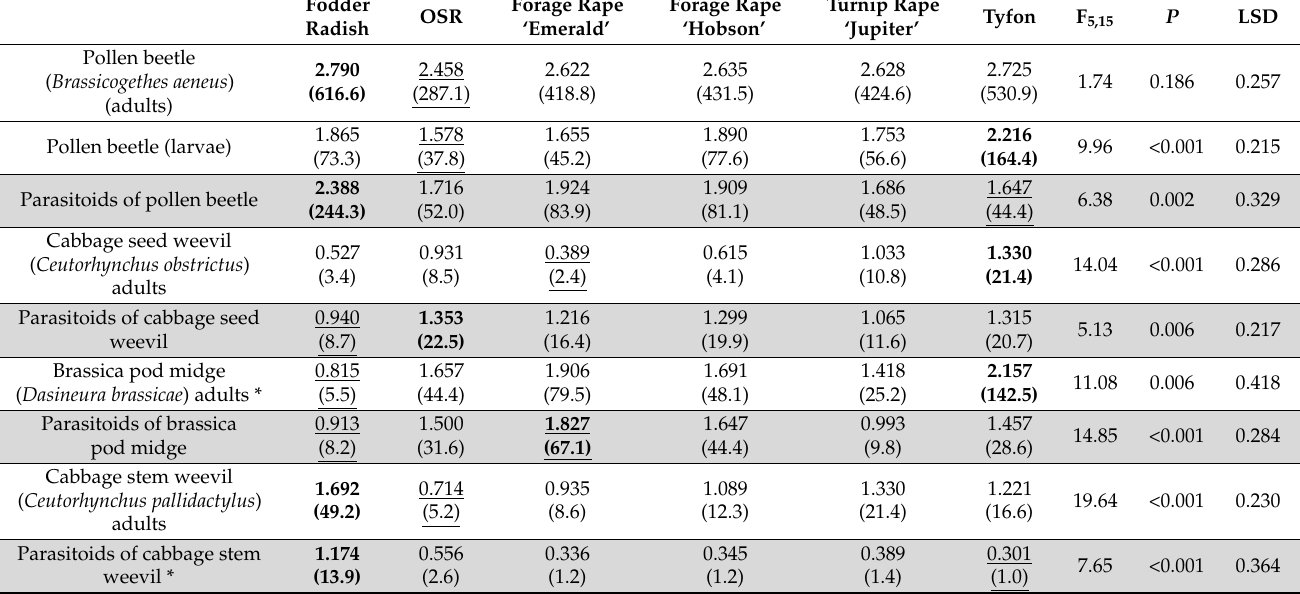
Table 2. Whole-season means (log scale), and underneath in brackets back transformed means, of oilseed rape pests (white rows) and their parasitoids (shaded rows) collected by suction sampling from plots ( n = 4) of different Brassicaceae: Fodder radish ( Raphanus sativus ) cv Apoll; Oilseed rape (OSR; Brassica napus ) cv Castille; Forage rape ( Brassica napus ) cv Emerald and cv Hobson; Turnip rape ( Brassica rapa ) cv Jupiter and Tyfon (a hybrid of B. rapa Rapifer group × B. rapa Pekinensis group). Asterisks (*) indicate use of an offset. Smallest population underscored, largest population bold. Fodder Forage Rape Forage Rape Turnip Rape OSR Tyfon F 5,15 P Radish ‘Emerald’ ‘Hobson’ ‘Jupiter’